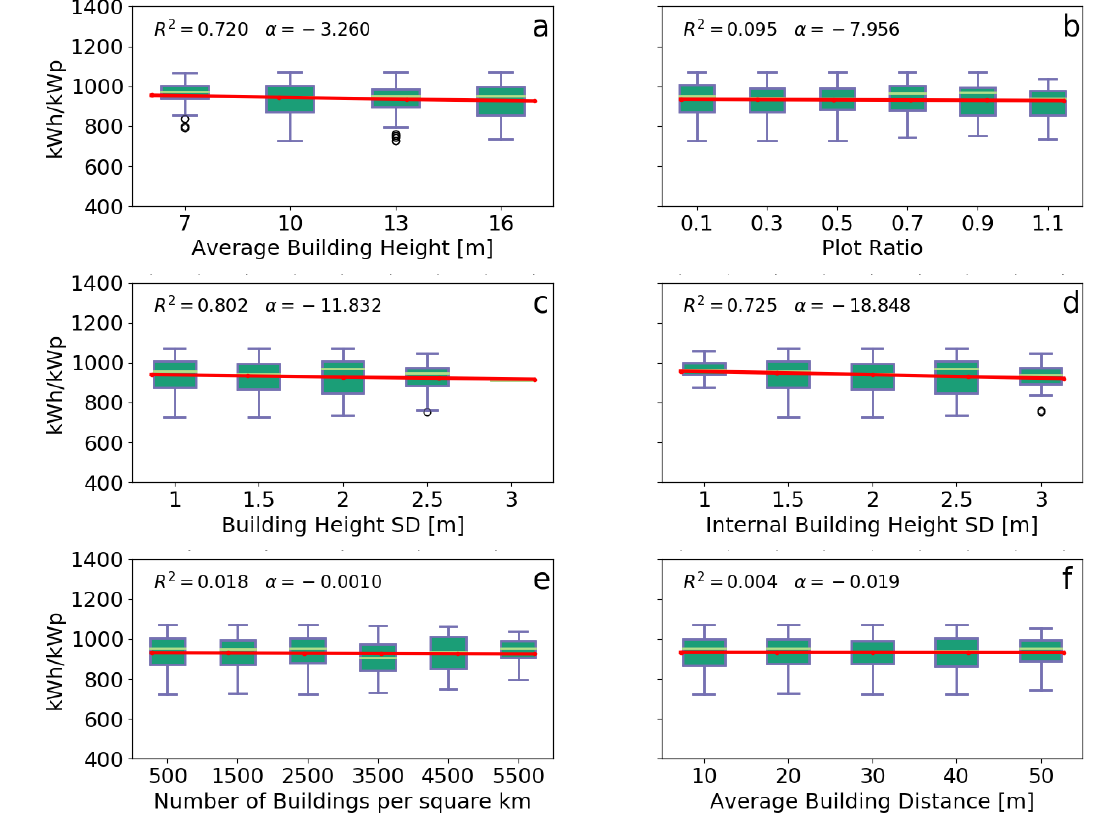
Figure 10. Comparison of Y f using linear regression with ( a ) ABH; ( b ) plot ratio; ( c ) BHSD; ( d ) IBHSD; ( e ) number of buildings per km 2 ; ( f )